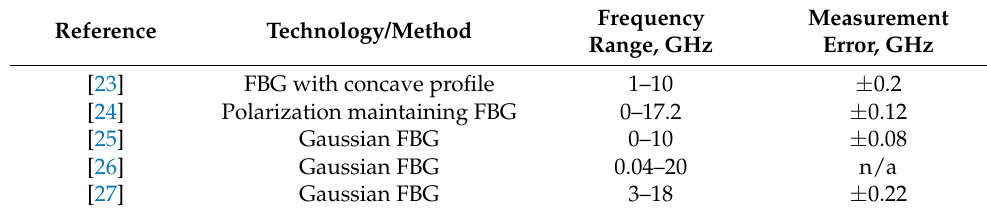
Table 2. Performance of IFM techniques based on